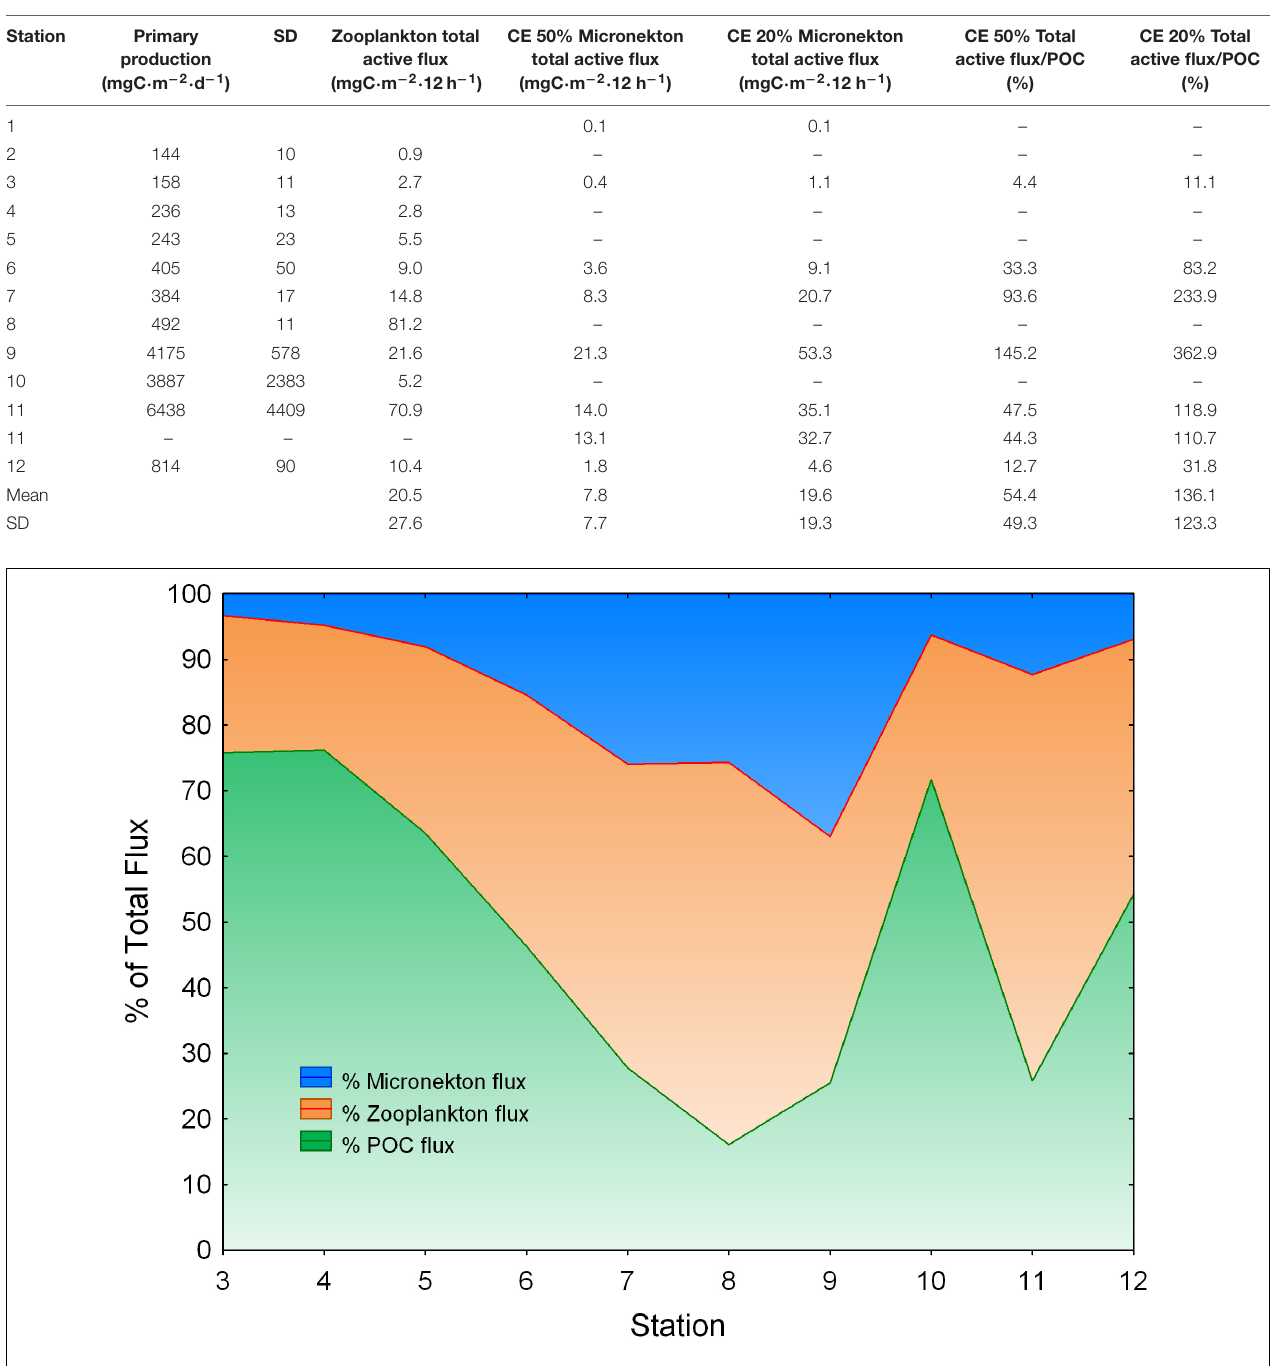
TABLE 3 | Total active flux estimated as the sum of respiratory flux and estimated mortality, excretory, and gut flux performed by zooplankton and micronekton in comparison to primary production obtained by remote sensing (VGPM model) and POC flux obtained using sediment traps. Station